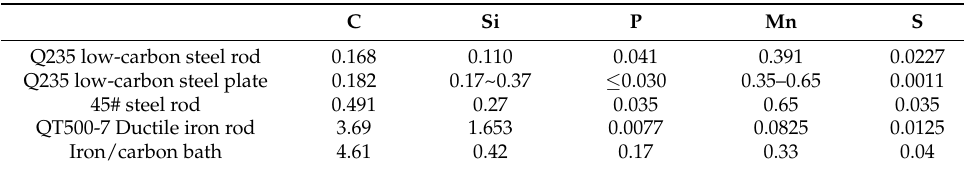
Table 1. Material composition